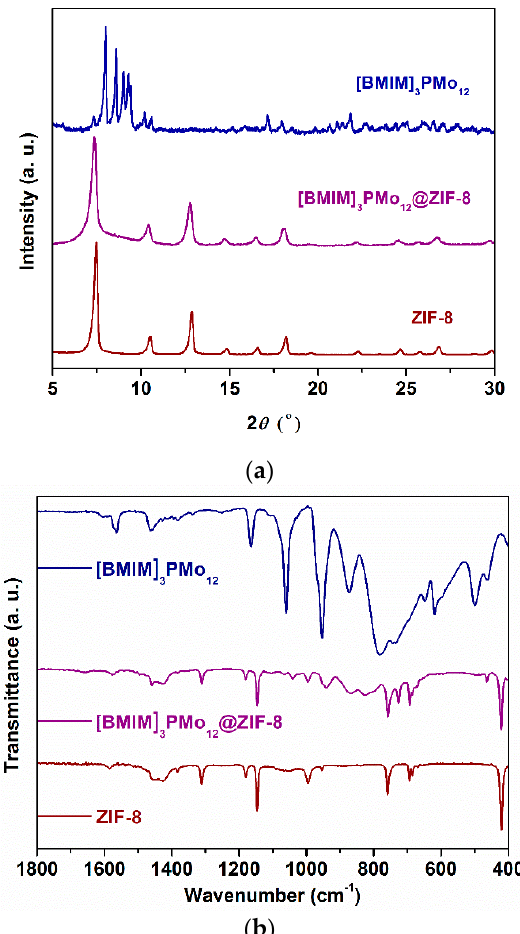
Figure 1. PXRD patterns ( a ) and FT-IR spectra ( b ) recorded for the pristine ZIF-8 compound and composite [BMIM] 3 PMo 12 @ZIF-8. composite [BMIM] 3 PMo 12